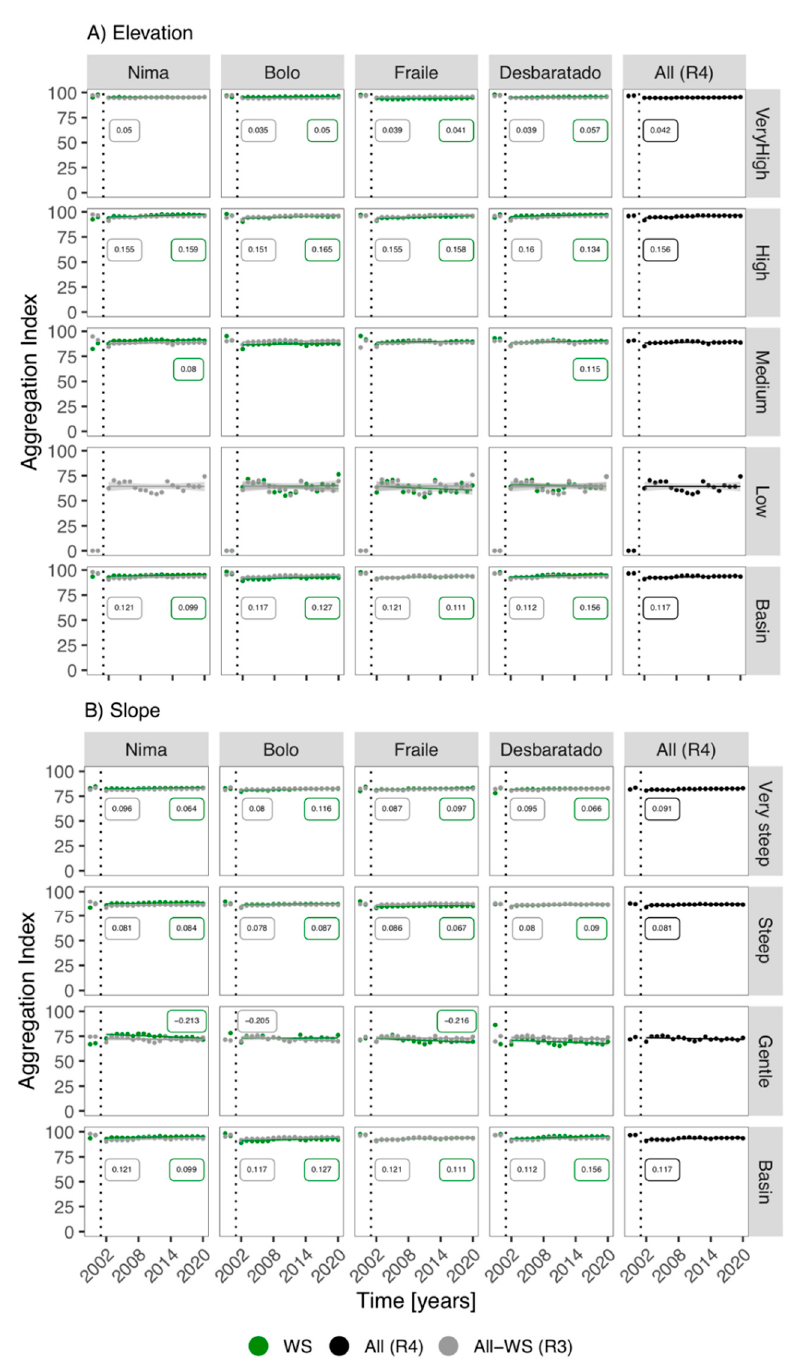
Figure 5. Temporal variation of index of aggregation ( AI i ) as a function of ( A ) elevation and ( B ) slope at regional (black; R4), watershed (green; WS i ), and sub-regional (grey: R3) scales. The vertical dotted line separates the historic and current datasets. Numbers within rectangles represent significant slopes in linear models.